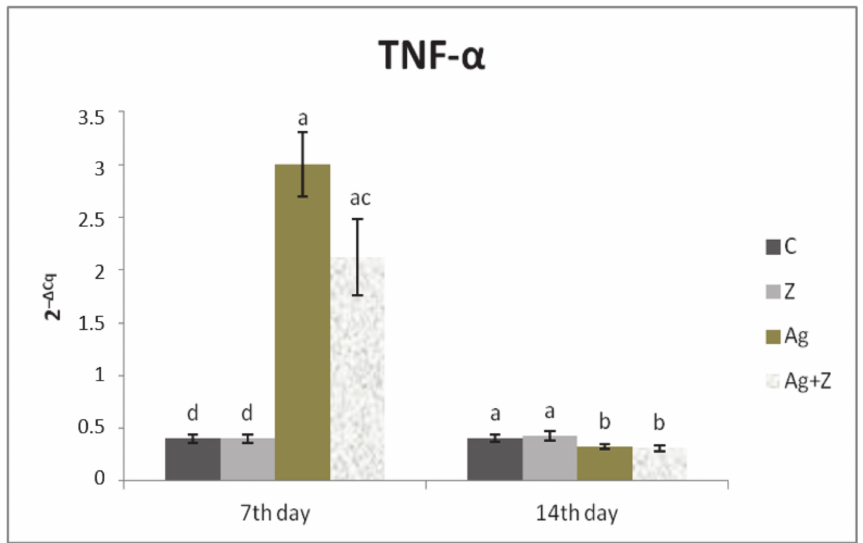
Figure 4. Relative expression of TNF- α gene in the jejunum of chickens treated with inorganic ZnSO 4 and infected by A. galli . Results at each time point are the median of 2 − ∆ Cq . Means with different superscripts are significantly different. ab p < 0.05; ac p < 0.01; ad p <